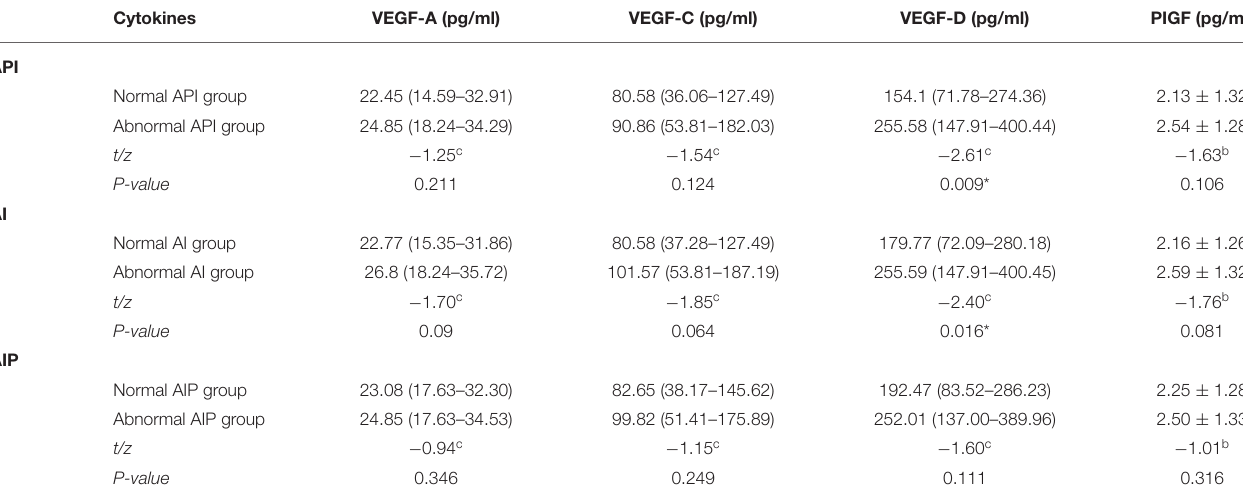
TABLE 2 | Comparison of the circulating level of VEGF-A, VEGF-C, VEGF-D, and PlGF in patients with abnormal and normal arteriosclerosis-associated plasma indices (API, AI, AIP). Cytokines VEGF-A (pg/ml) VEGF-C (pg/ml) VEGF-D (pg/ml) PIGF (pg/ml)